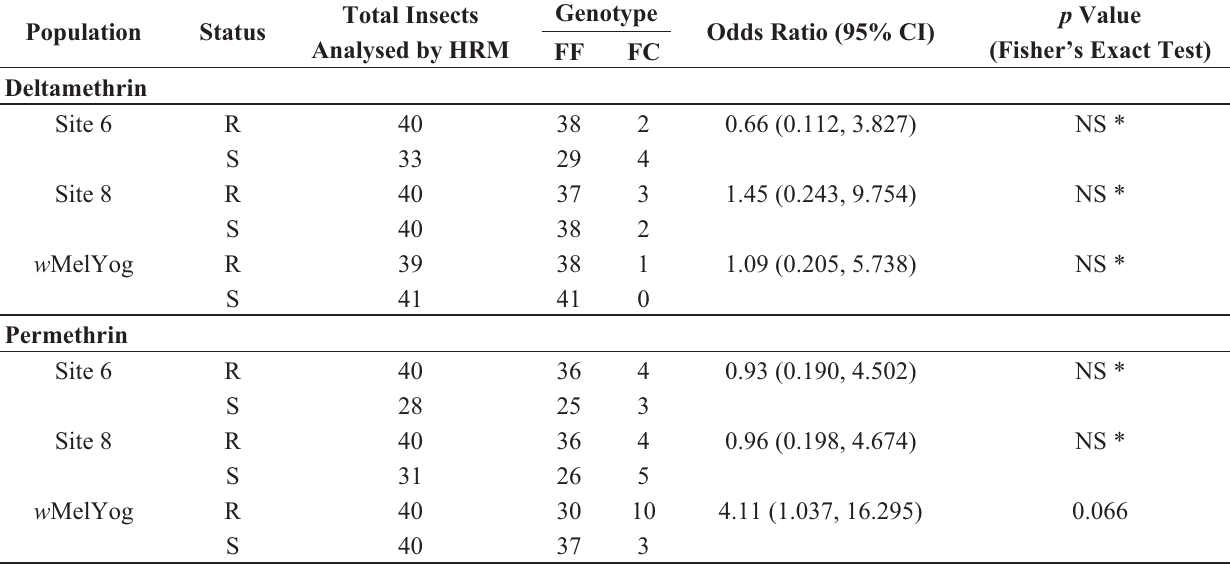
Table 5. Association between homozygote and heterozygote Vssc F1565C alleles with Aedes aegypti mosquito susceptibility to permethrin and deltamethrin from Yogyakarta (CC genotype was rare and odds ratio could not be